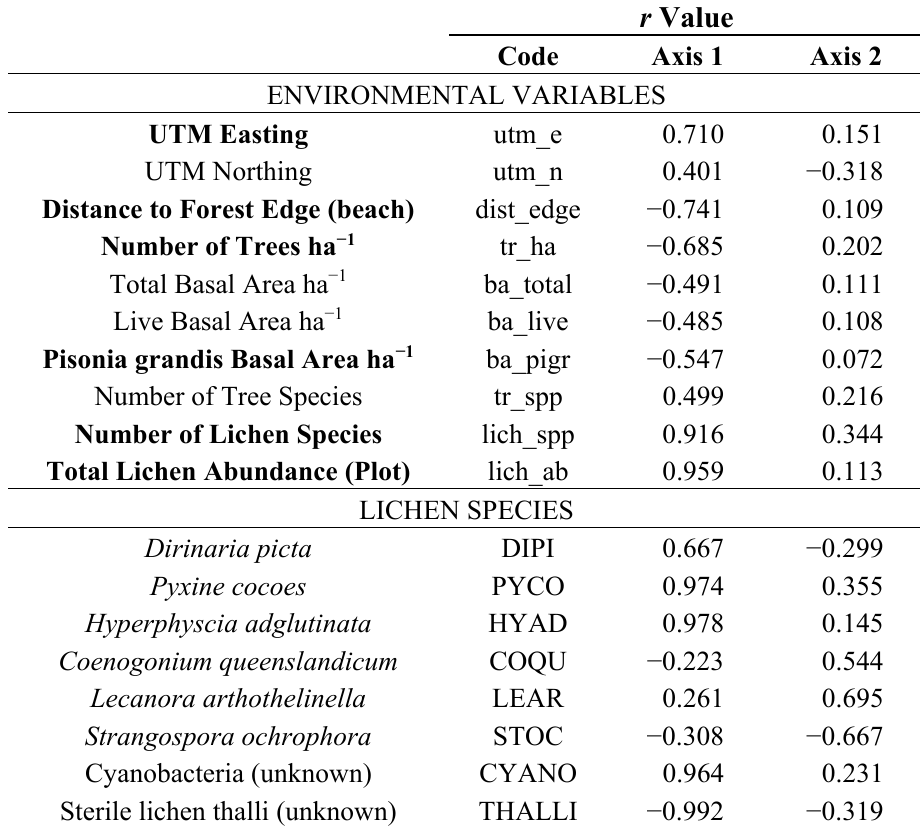
Table 4. Coefficients of determination for correlations between environmental variables, lichen species, and primary ordination axes. Variables in boldface have r values >0.5 or < −